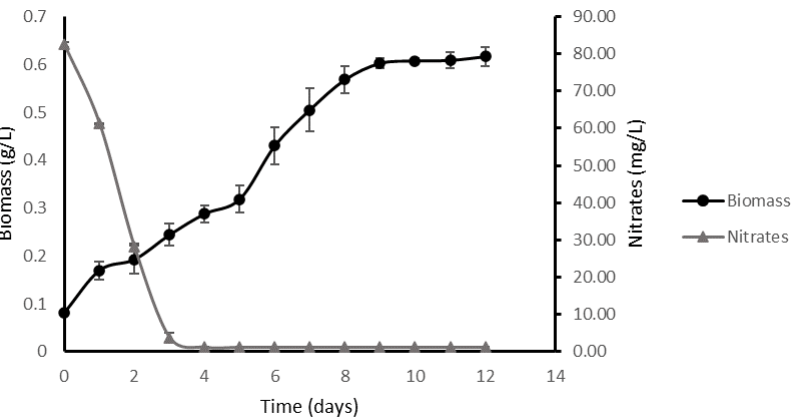
Figure 1. Growth kinetics of M. salina in low-density batch cultures. Growth curve expressed in dry microalgae biomass (g/L) and dissolved nitrates (mg/L) in batch culture under low-density conditions as a function of time. The culture was harvested 8 days after the total nitrogen depletion in the culture medium.